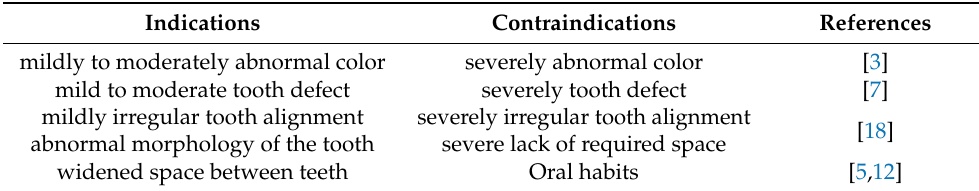
Table 2. The indications and contraindications of